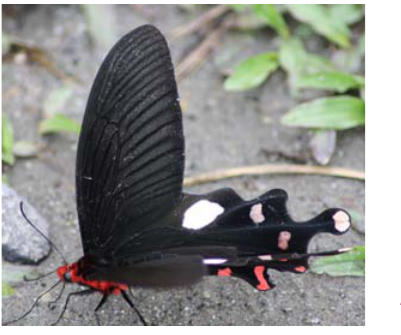
Image 18. Byasa polla